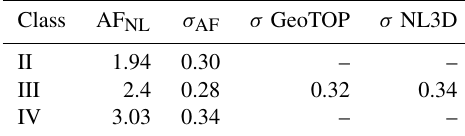
Table 2. Amplification factors and standard deviations ( σ ) for the NL classification. σ AF is the uncertainty when a local (HVSR) recording is available. σ GeoTOP and σ NL3D represent the addi- tional uncertainty associated with the GeoTOP and NL3D